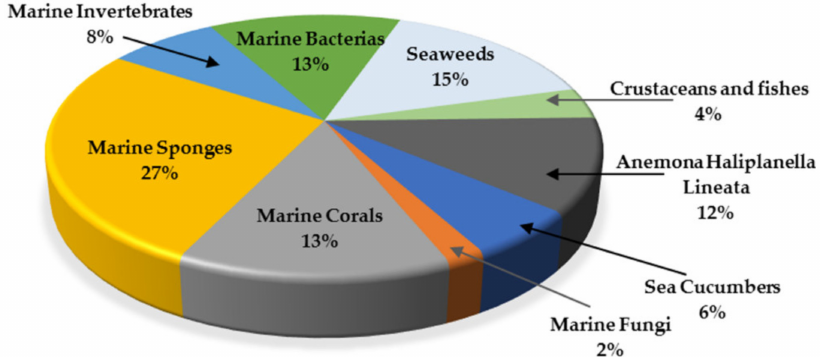
Figure 20. Marine organisms as sources of anti-glioma compounds.